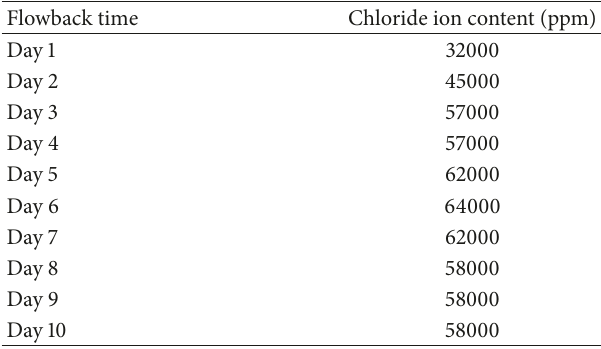
Table 3: Change of chloride ion content in flowback fluid in different flowback